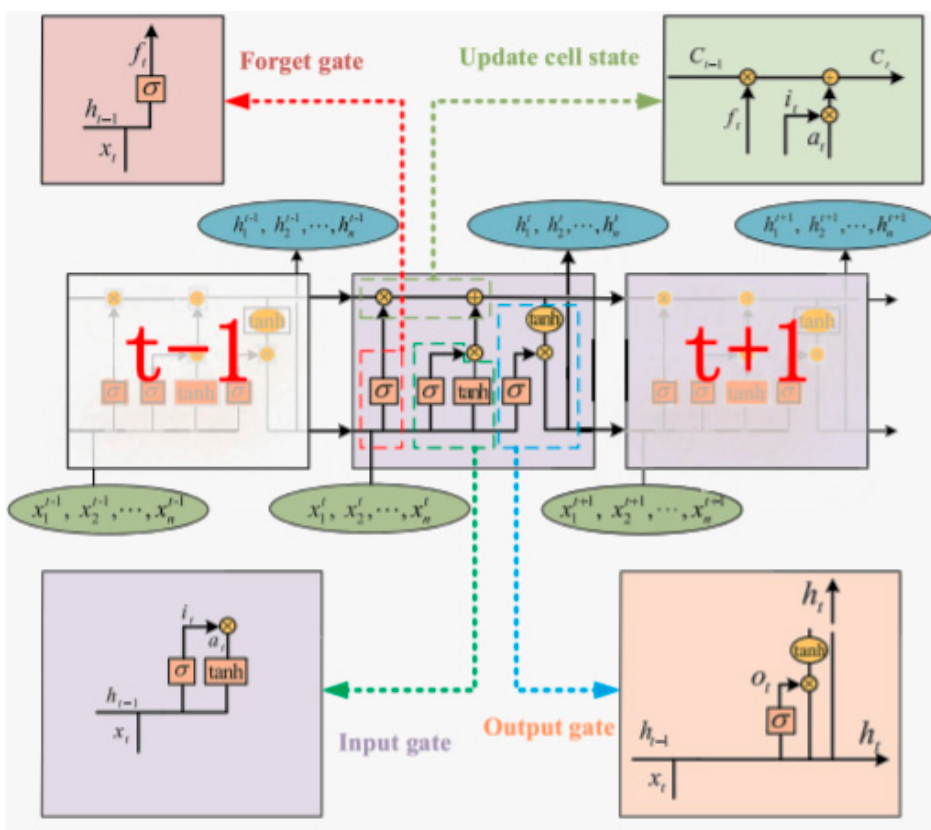
Figure 11. Network architecture of LSTM .